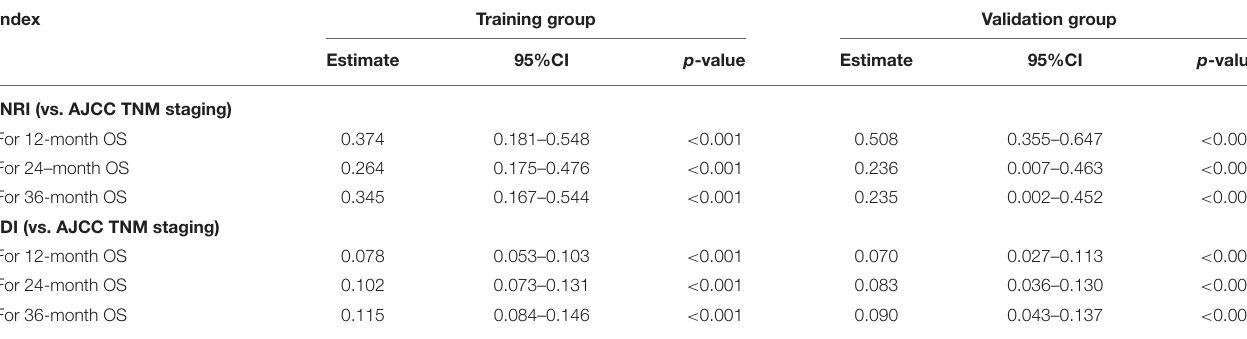
TABLE 3 | NRI and IDI of the nomogram in survival prediction for elderly patients with CHS compared with TNM staging system. Index Training group Validation group Estimate 95%CI p -value